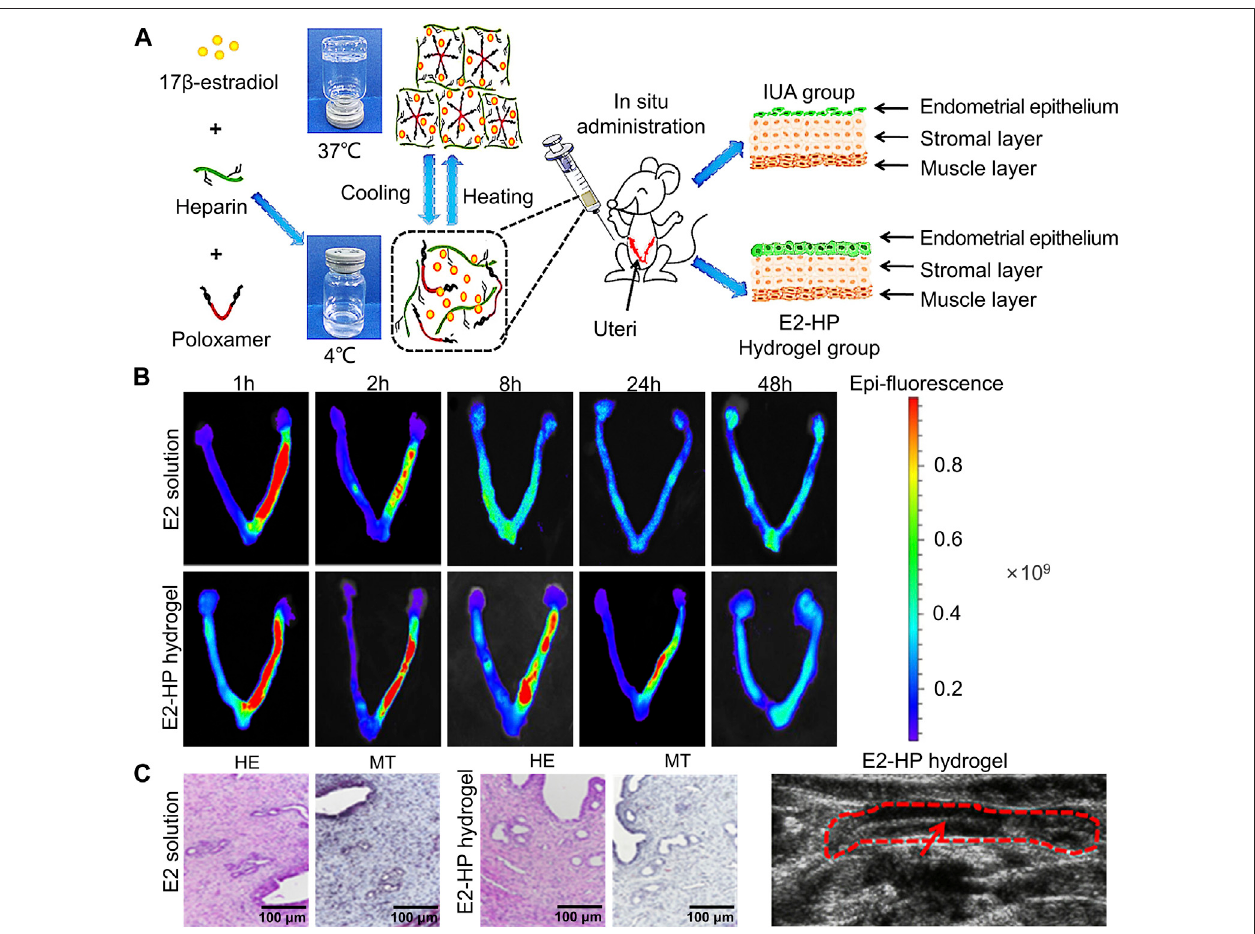
FIGURE 2 | Construction of E2-HP hydrogel and in-situ administration effect. (A) Schematic diagram of E2-HP hydrogel as an in-situ administration drug for the treatment of IUA. (B) The penetration and retention of different FITC-E2 formulations in the uterus after in-situ administration. (C) Comparison of H&E staining (HE) and Masson ’ s staining (MT) of endometrium at 14 days after different treatments. (D) Ultrasound images of the endometrium after E2-HP hydrogel treatment. Reproduced with permission (Zhang et al., 2017). Copyright 2021 Dove Press